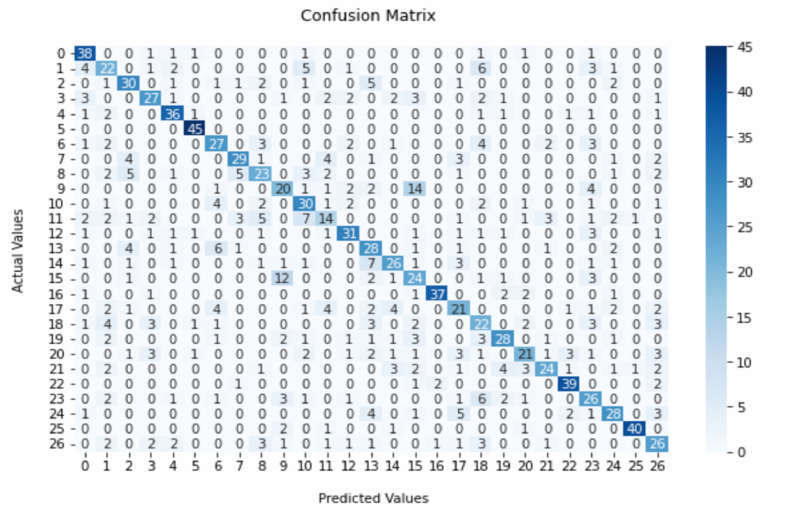
Figure 11. Confusion matrix for XGBoost-based classification with MFCC and augmented data.